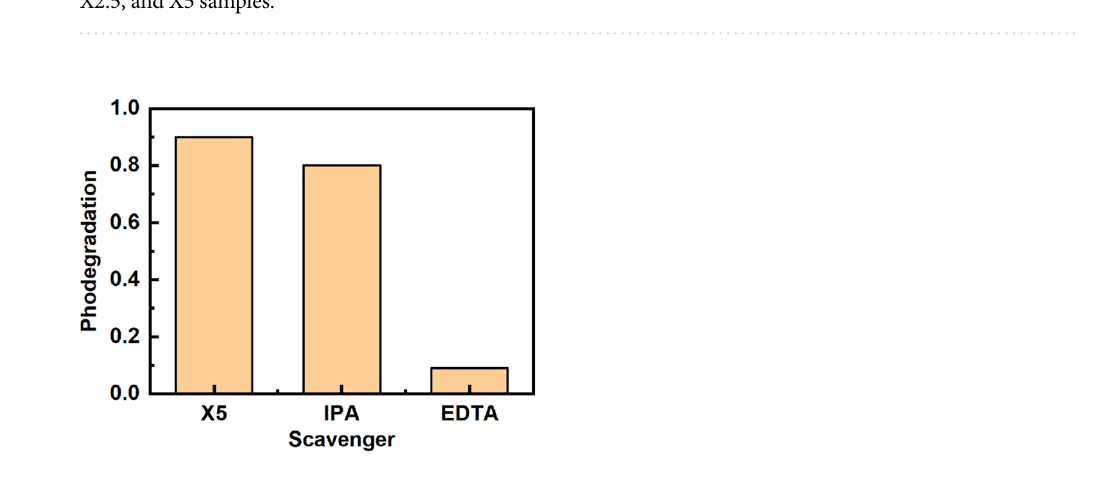
Figure 5. ( a ) Schematic of the band structure and charge transfer mechanism and ( b ) PL spectra of the g-C 3 N 4 , X2.5, and X5 samples.